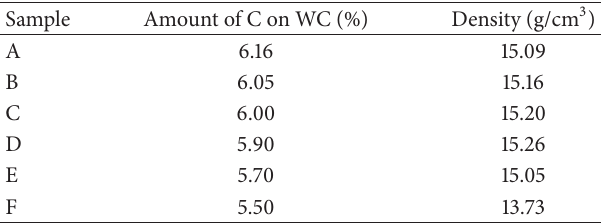
Table 1: Amount of C on WC and density of the samples.